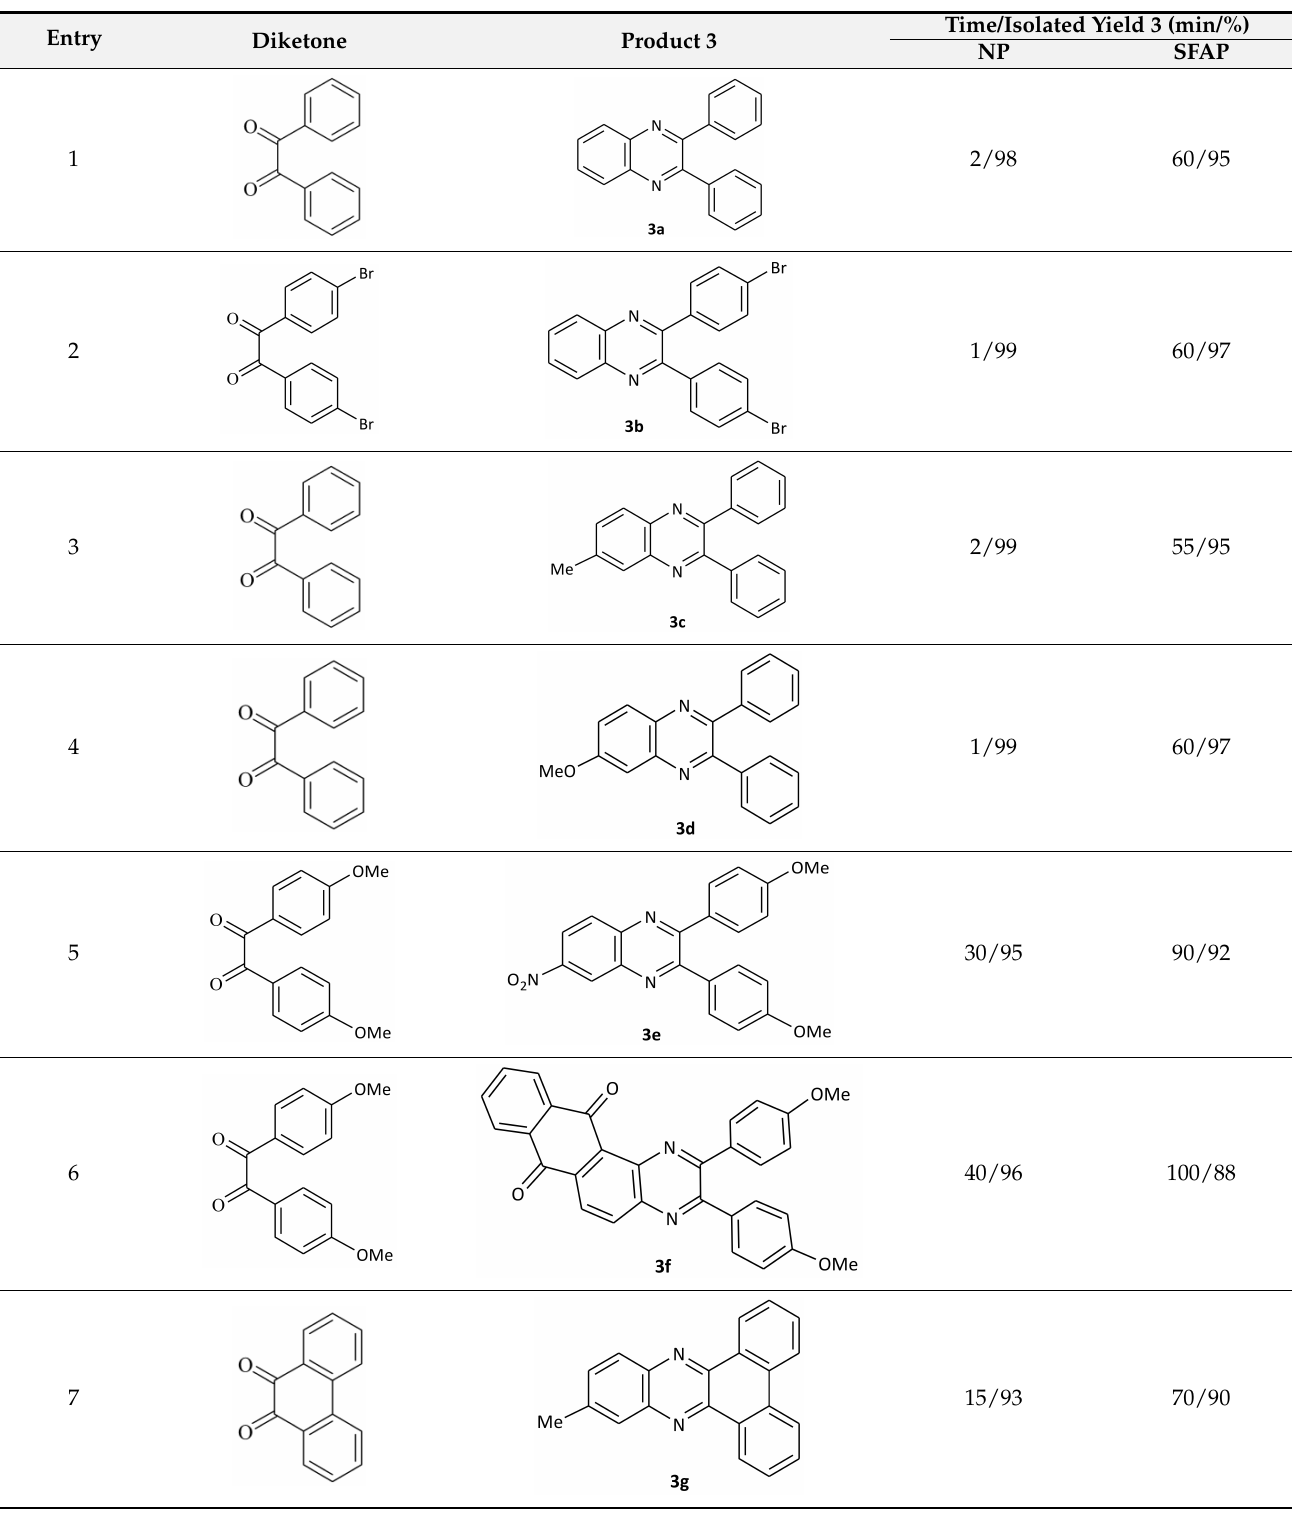
Table 5. Synthesis of quinoxalines 3 by using NP and SFAP as